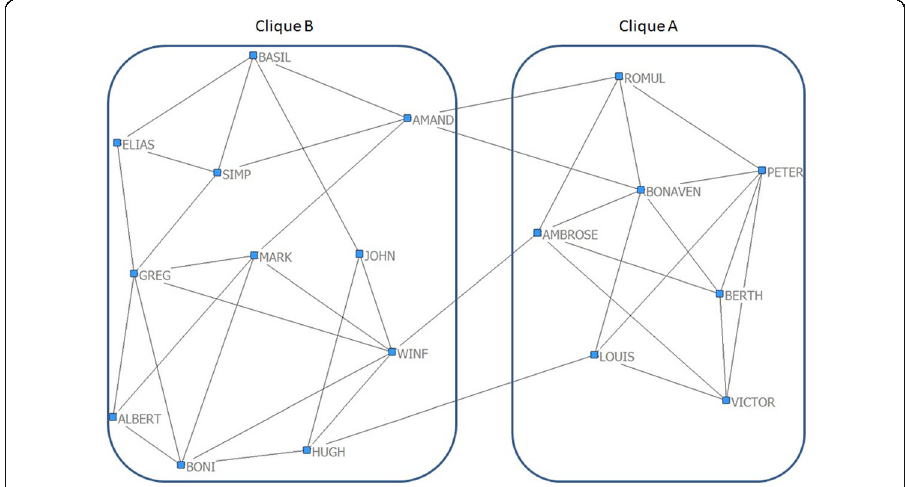
Fig. 2 The like relation between 18 monks from Sampson ’ s Monastery social network dataset (Sampson 1968). Monks are arranged into two cliques as in Bonacich and Lloyd